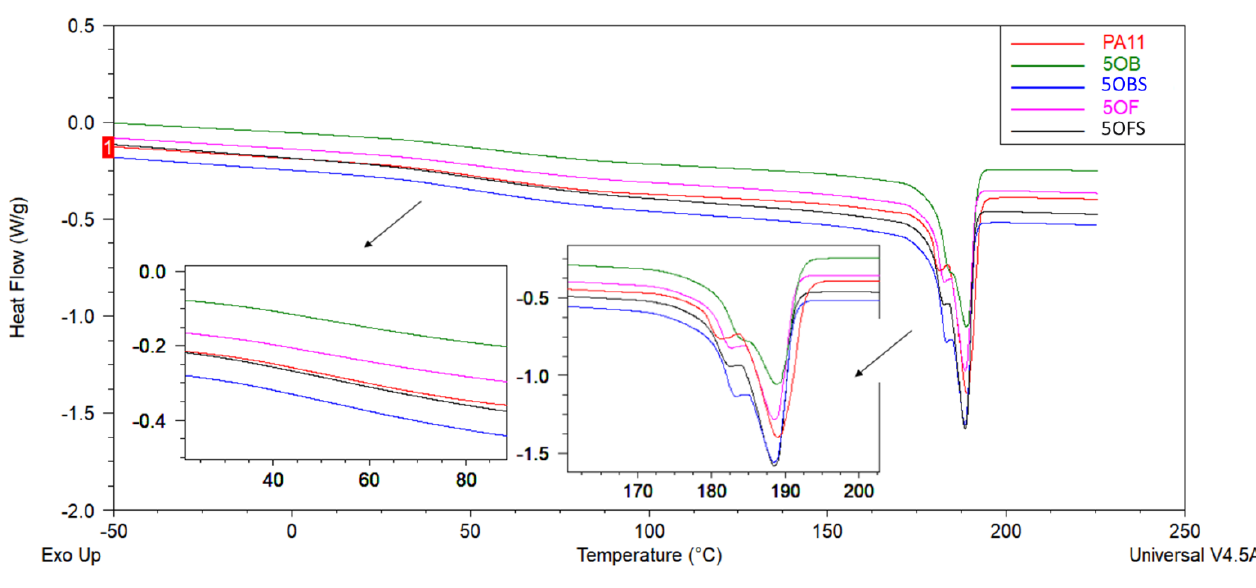
Figure 13. DSC curves of unmodified PA11 and composites, second heating; samples with 5% of diatoms. Table 4. Thermal characteristics of PA11 and composites with